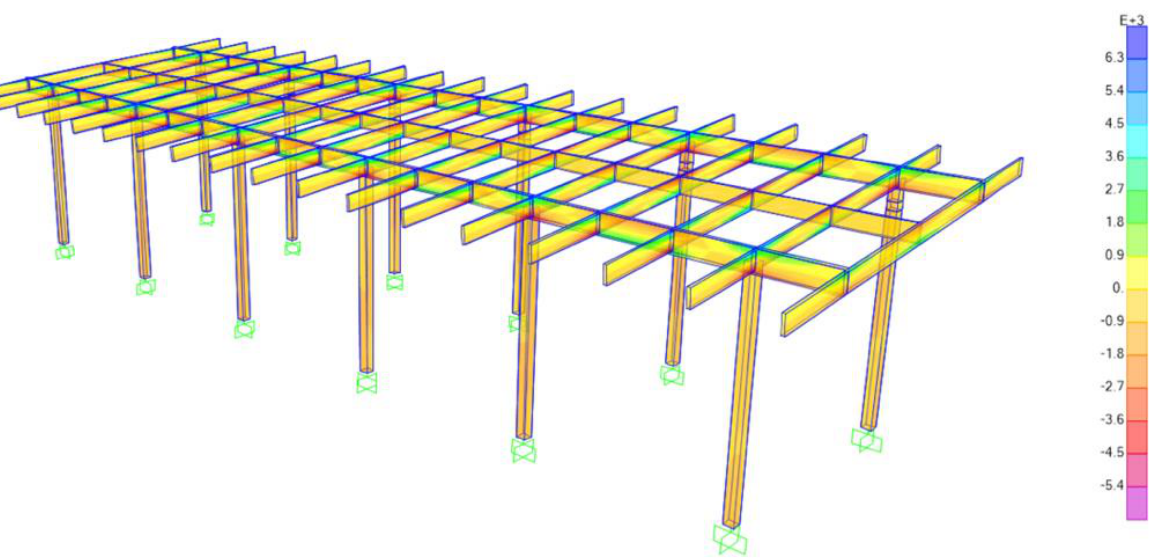
Figure A6. Stress contour in kPa of the Single-Span System with a finite element analysis.